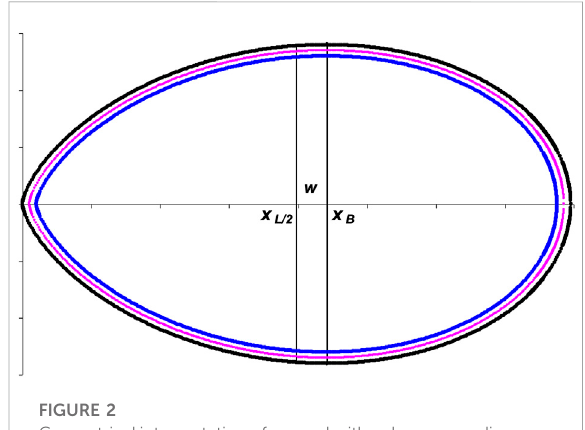
FIGURE 2 Geometricalinterpretationofavesselwithashapeaccording to Narushin ’ s